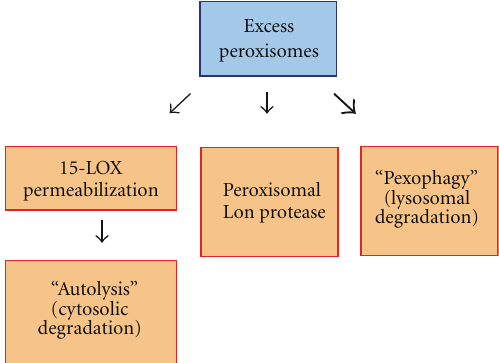
Figure 6: Peroxisome degradation pathways in mammalian cells. Surplus peroxisomes or their contents (e.g., peroxisomal matrix proteins) can be degraded by at least three distinct mechanisms: Lon protease-mediated proteolysis, 15-lipoxygenase (15-LOX)-mediat- ed cytosolic degradation (autolysis), and pexophagy (autophagy- mediated lysosomal degradation). Current studies suggest that the majority of peroxisomes are degraded by pexophagy (indicated by bold